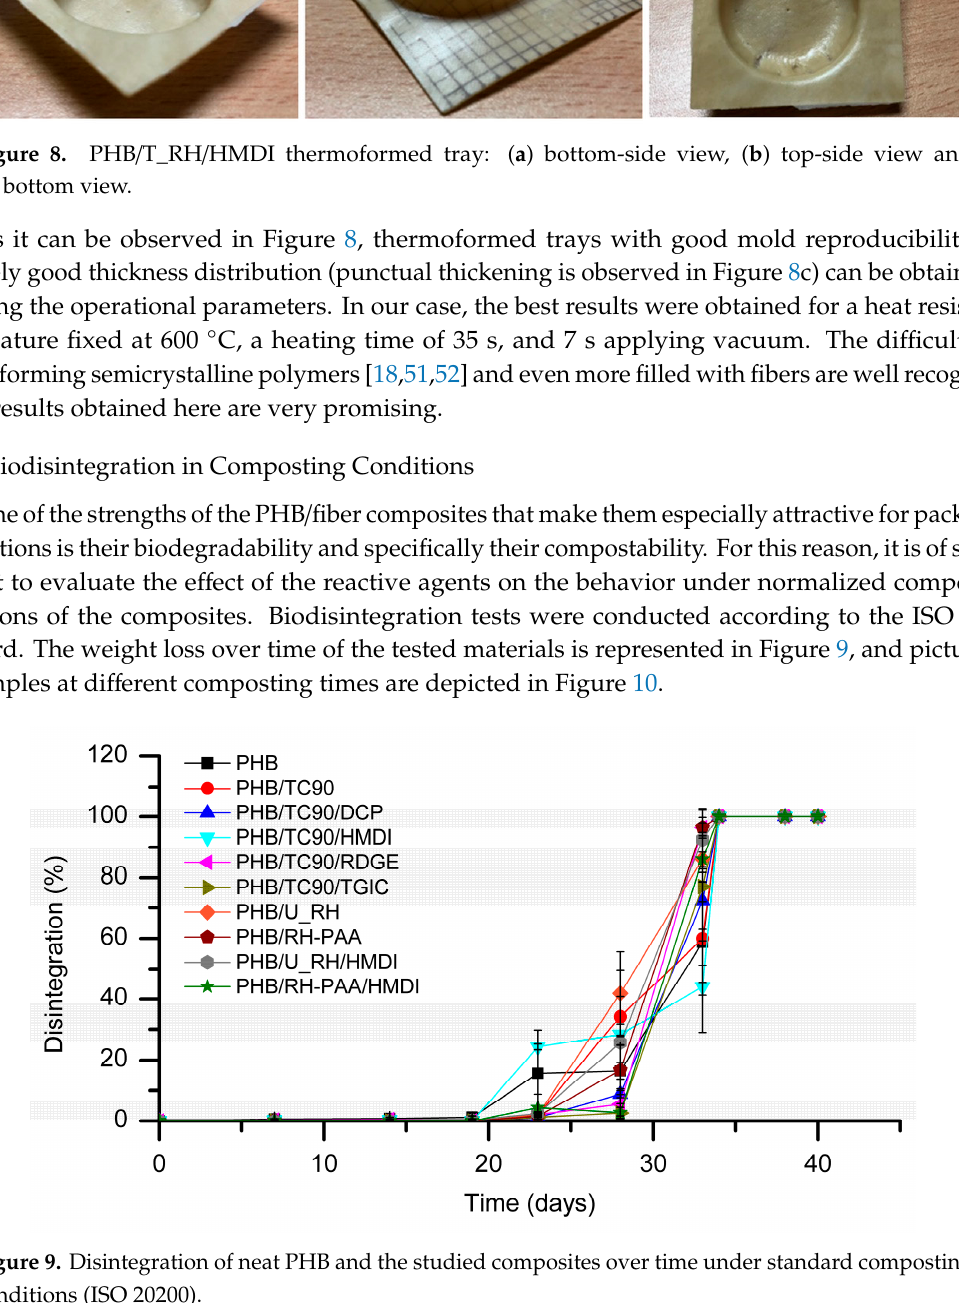
composting conditions (ISO 20200). conditions (ISO Figure 9. Disintegration of neat PHB and the studied composites over time under standard